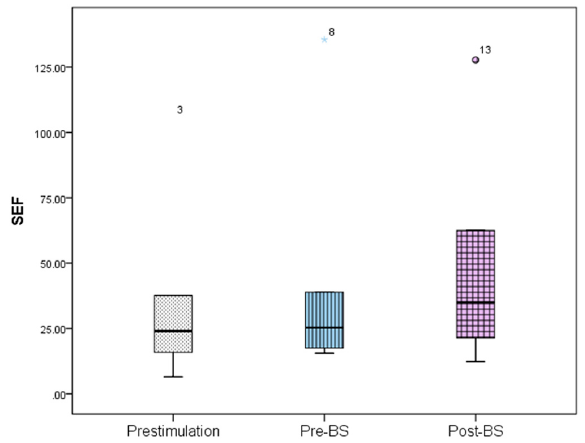
Figure 7. Spectral edge frequency (SEF) variation for the prestimulation, pre-BS period, and post-BS